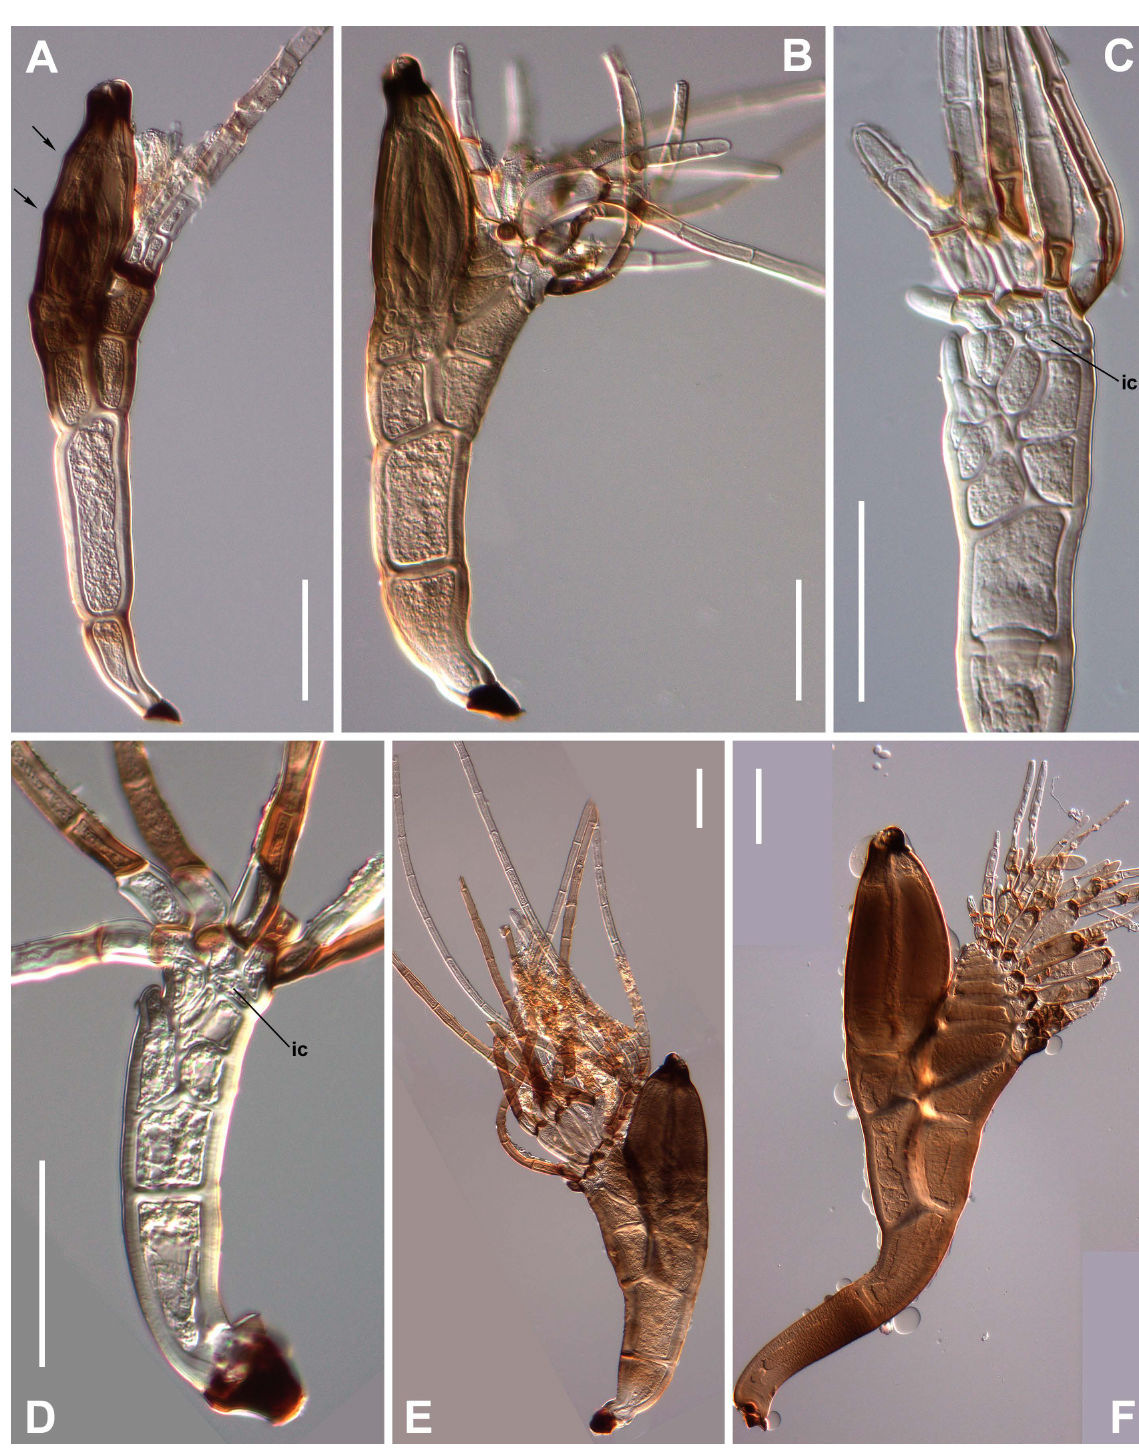
Fig. 31. Laboulbenia spp. A . L. eubradycelli Huldén. Mature thallus showing elevations on ventral margin of perithecium (arrows). – B – F . L. fasciculata Peyr. B , E . Mature thalli. C – D . Immature thalli with labelled insertion cell (ic). F . Mature thallus on Chlaenius from Spain. Scale bars: 50 µm. Photographs from slides ZMUC C-F-122533 (A), ZMUC C-F-124273 (B), ZMUC C-F-123598 (C), ZMUC C-F- 122639 (D–E), BCB-XE56